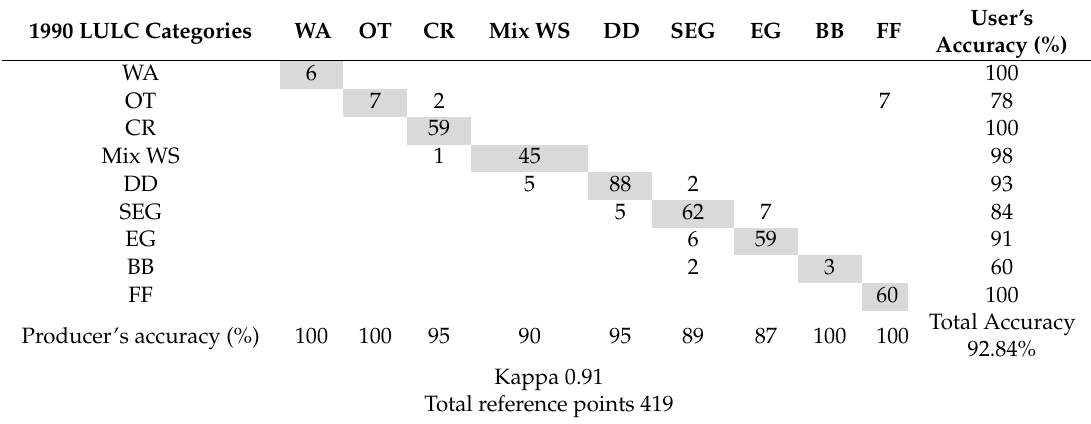
Table A1. Results of the accuracy assessment of the PBTC land cover map for 1990.